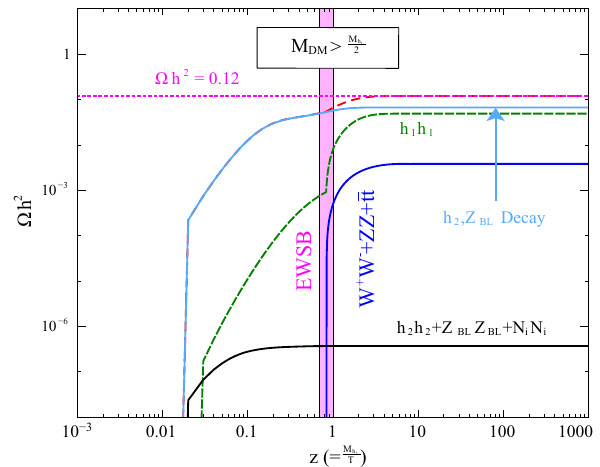
Fig. 12 Variation of the DM relic density (cid:9) h 2 with z . The other parameter values have been kept fixed at λ Dh = 6 . 364 × 10 − 12 , λ = 7 . 637 × 10 − 14 , n DH = 3000 GeV, g M Z BL GeV, α = 10 − 5 , M N